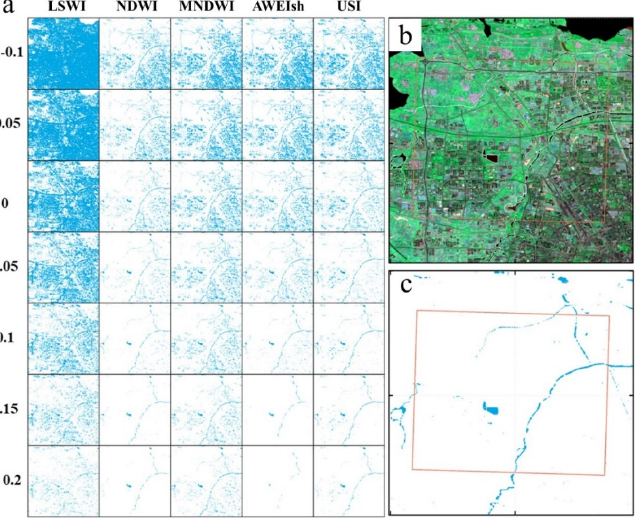
Figure 7. Experimental area B for comparison of water body extraction methods: ( a ) extraction results using different water body indexes with different thresholds, ( b ) real water profile, and ( c ) results obtained using the automatic urban surface water mapping (AUSWM)